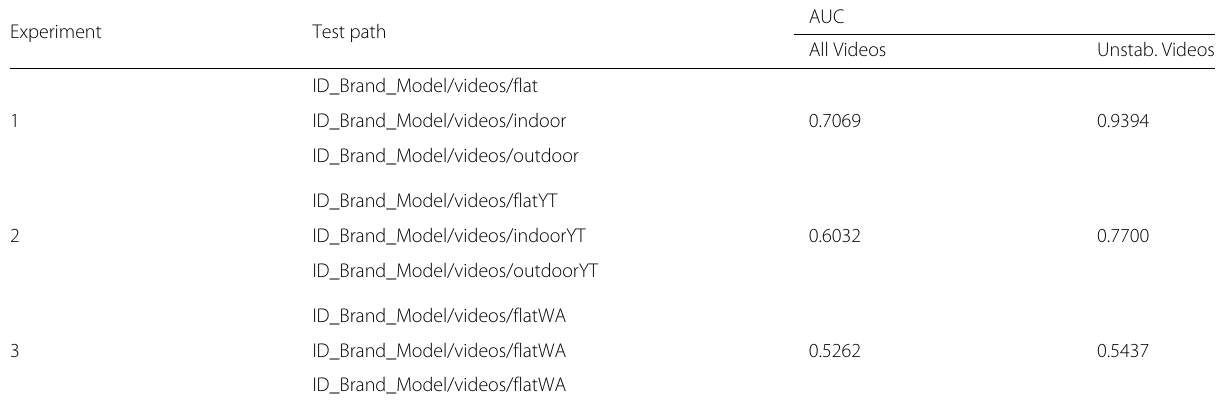
Table 3 Dataset paths for VSI experiments